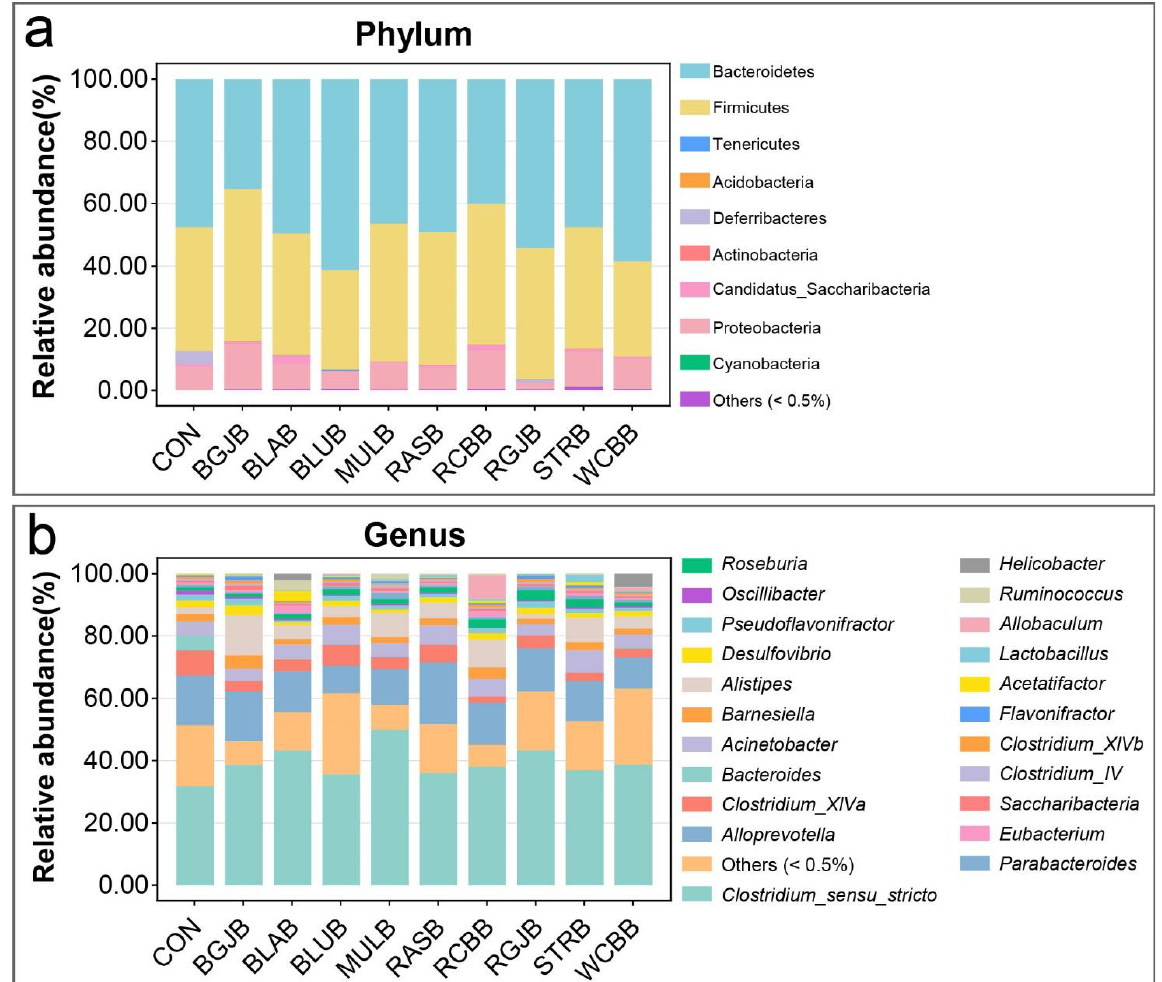
Figure 4. Bacterial taxonomic profiling at the ( a ) phylum level and ( b ) genus level of gut bacteria from different mouse groups (n = 7/group).